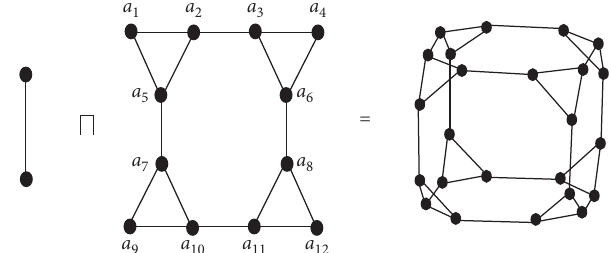
Figure 1: The molecular graph of truncated cube.